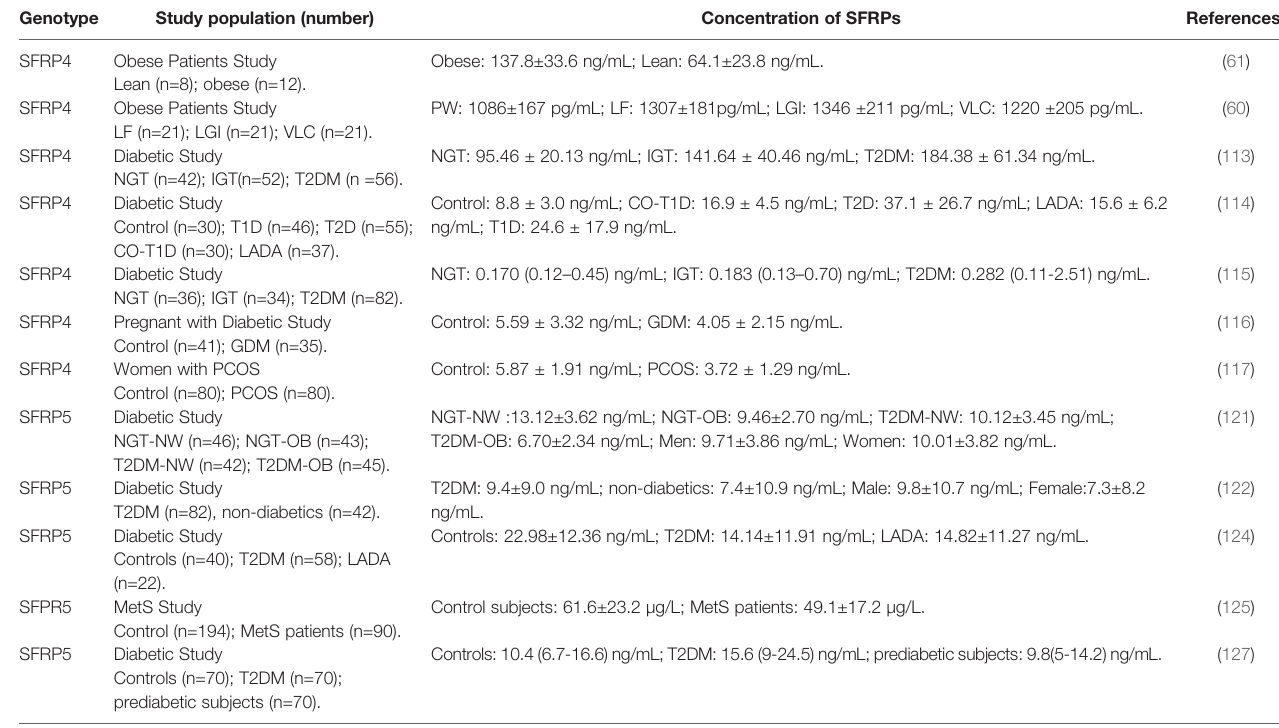
TABLE 2 | The clinic study about the concentration of SFRPs in patients with metabolism